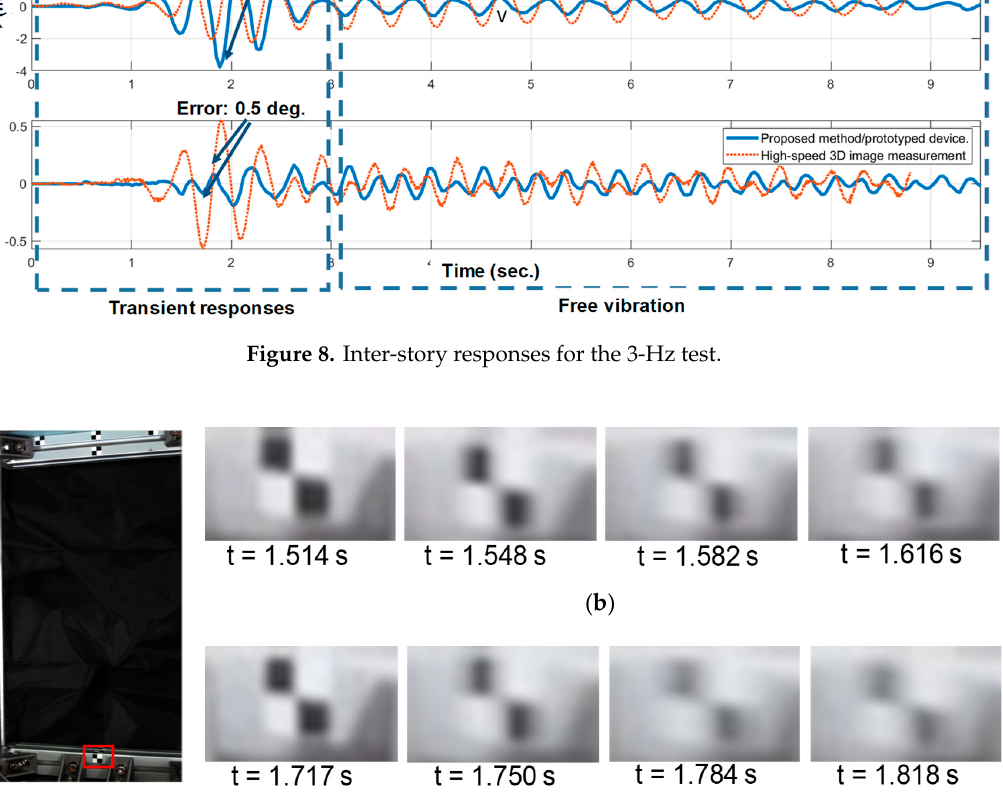
Figure 8. Inter-story responses for the 3-Hz test.